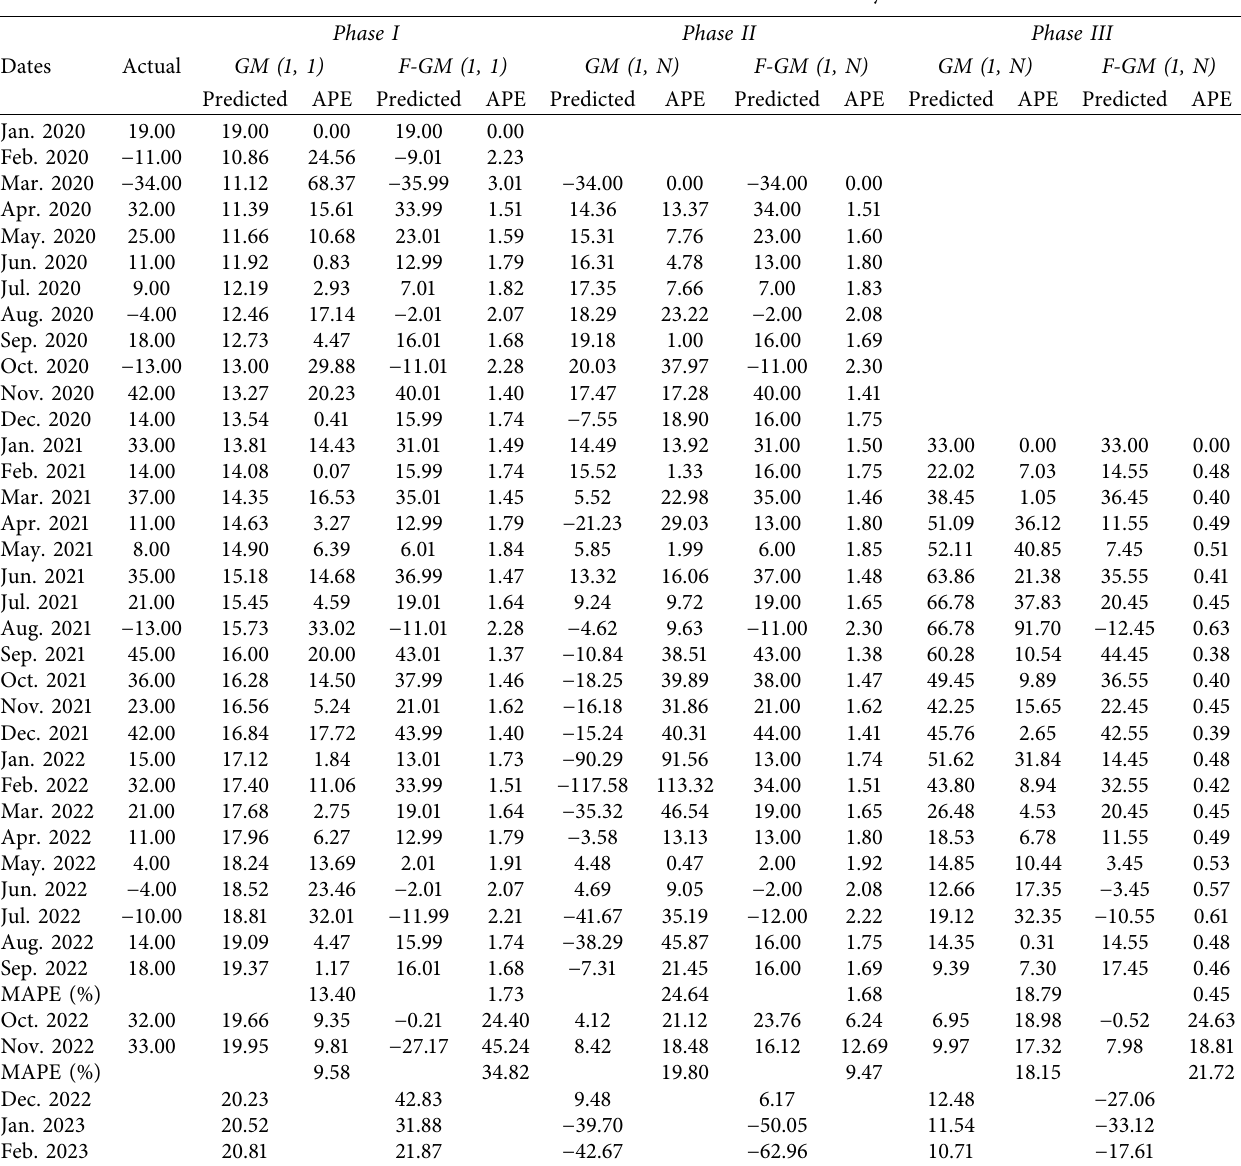
Table 12: Prediction results of travel sentiment in Turkey.